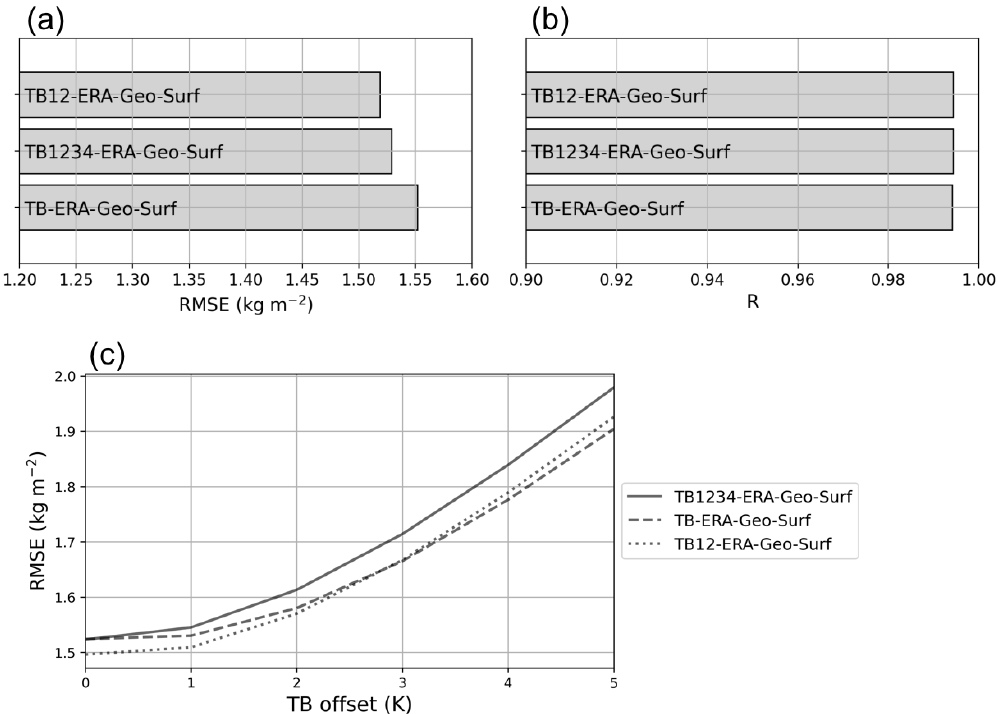
Figure A1. Effect of higher-order T B polynomials on IWV retrieval. Panels (a) and (b) show the RMSE and R for the testing set. It comes across that the best results are obtained with T B and T 2 illustrates how the RMSE changes when a constant T B offset is added to the testing input, simulating a miscalibration of the radiometer. In terms of relative increase, the retrieval with T B only is slightly less affected, but it does not bring a large enough improvement to be considered preferable in comparison with the retrieval with T B and T 2